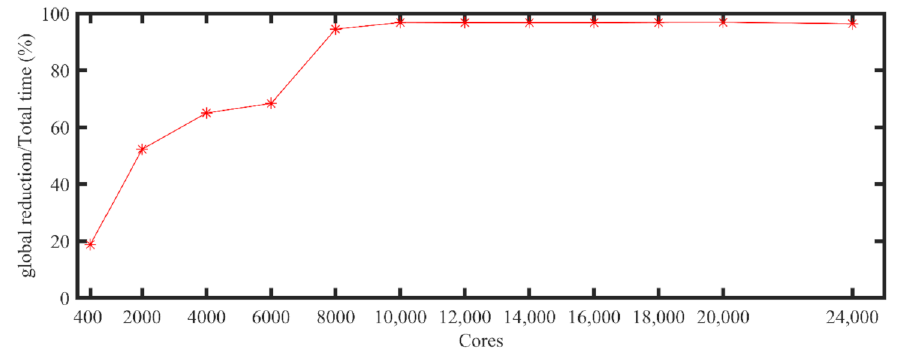
Figure 2. Percentage of the global reduction (MPI_Allreduce) time of the total execution time in the 5-km NEMO experiment with the PCG